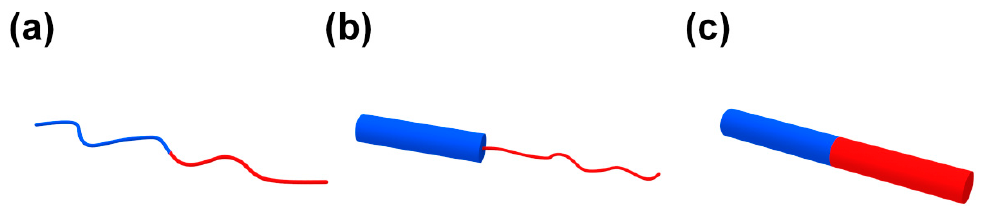
Figure 3. ( a ) Conventional “coil–coil” block copolymers (BCPs); ( b ) “rod–coil” conjugated block copolymers (cBCPs); and ( c ) “rod–rod” cBCPs.